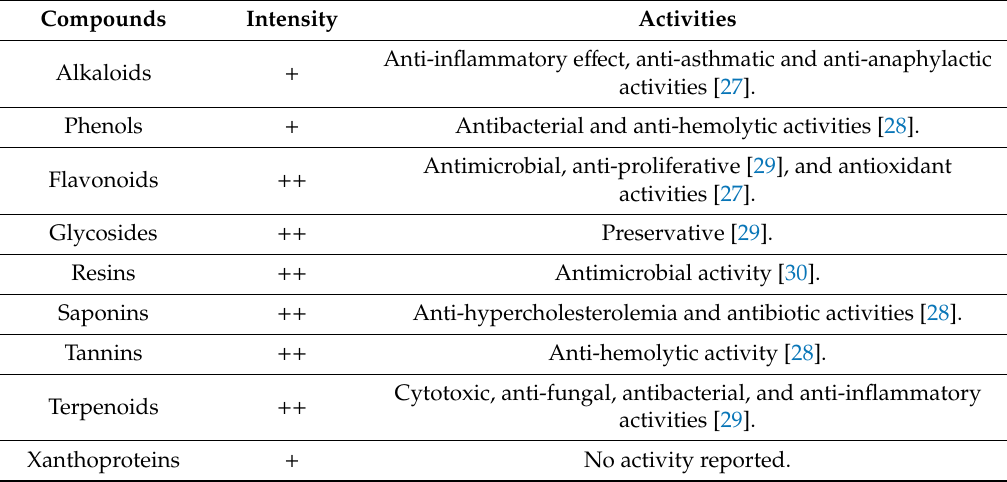
Table 1. Phytochemical screening of royal jelly and bioactivities of the compounds. Compounds